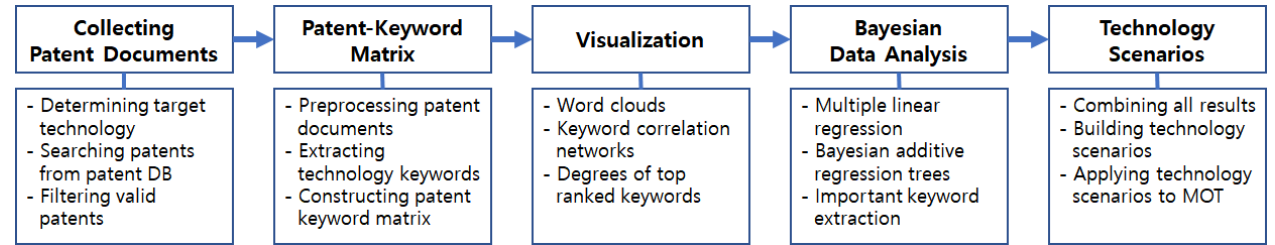
Figure 5. Correlation network structure.